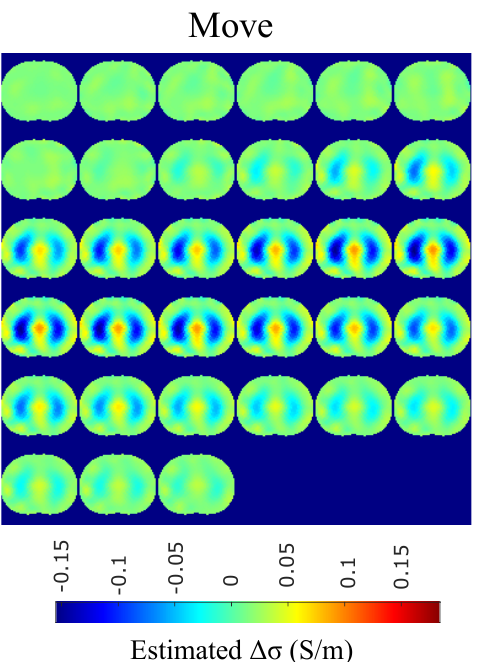
Figure 16. Single–breath in-vivo results using the movement Laplace prior